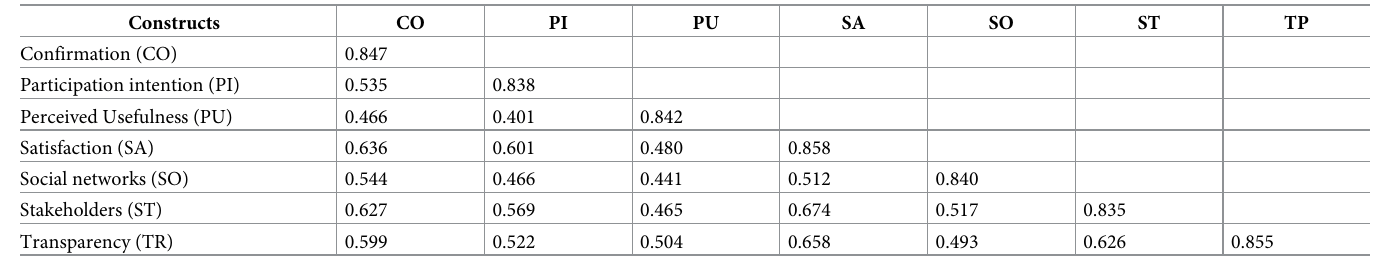
Table 4. Fornell-Larcker criterion.